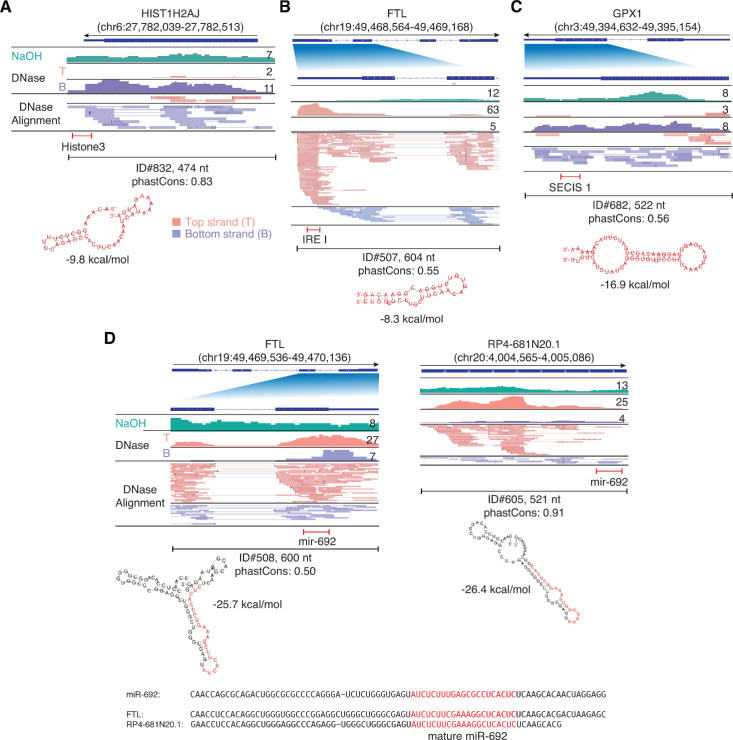
IGV screenshots showing examples of peaks mapping to exons or pseudogenes that contain regions classified by Infernal/Rfam (Kalvari et al., 2018) as belonging to known classes of structured RNAs.(A) A segment of peak near the 3’ end of HIST1H2AJ mRNA that contains a histone 3’-UTR stem-loop structure. (B) A segment of a peak in the 5’ UTR of FTL (ferritin light chain) mRNA that contains an iron response element I (IRE I). (C) A segment of a peak near the 3’ end of GPX1 mRNA that contains a selenocysteine insertion sequence 1 (SECIS 1). (D) Segments of peaks near the 3’ ends of FTL and a pseudogene that are predicted to fold into a pre-miRNA-like stem-loop structure for a miRNA with sequence similarity to mouse miR-692 (sequence alignments shown below). Gene names are indicated at the top with the hg19 coordinates of the called peak in parentheses and an arrow below indicating the 5’ to 3’ orientation of the encoded RNA. The top track shows the gene map (exons, thick bars; intron, thin lines), with the relevant part of the gene map expanded below if needed to visualize discussed features. The tracks below the gene map show coverage plots and read alignments for the peak region in combined datasets for NaOH-treated plasma DNA (n = 4; combined top and bottom strands, turquoise) or DNase-treated plasma RNA (n = 15; Top strand (T), pink and Bottom strand (B), purple) based on the number of deduplicated reads indicated at the right in the coverage tracks. Colors other than pink or purple in the read alignments indicate bases that do not match the reference sequence (red, green, blue, and brown indicate thymidine, adenosine, cytidine, and guanosine, respectively). The peak called by MACS2 is delineated by a bracketed line with the peak ID, length, and phastCons score for 46 vertebrates including humans indicated below (see phylogenetic tree in Figure 10 below). The bracketed red line indicates the portion of the peak corresponding to the identified feature, whose predicted secondary structure and MFE (ΔG) computed by RNAfold are shown below.